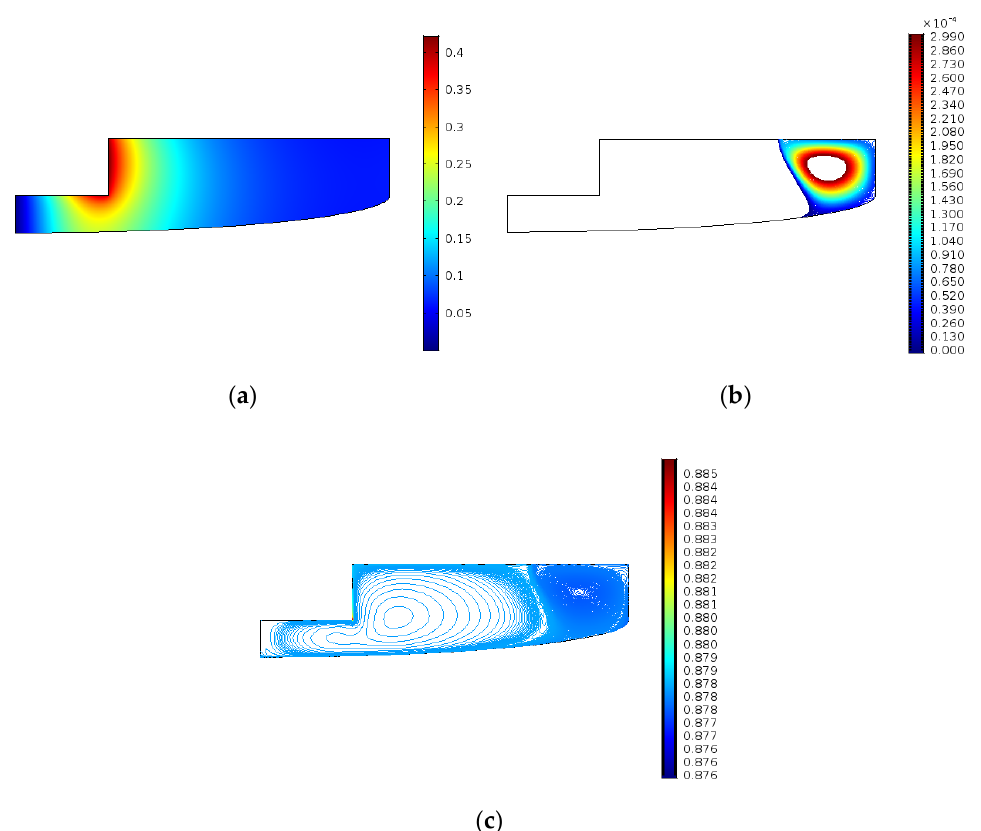
Figure 11. Results in case of the optimal solution after 4 h: ( a ) velocity field (m/s); ( b ) ECSO concentration (mol/m 3 ); ( c ) CO 2 concentration (mol/m 3 ).